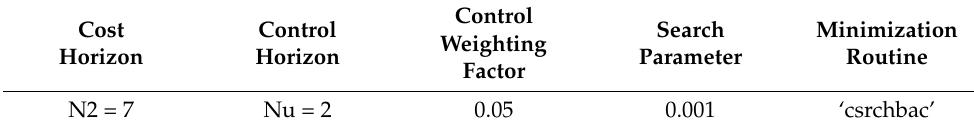
Table 2. The parameters of neural predictive controller results after training.